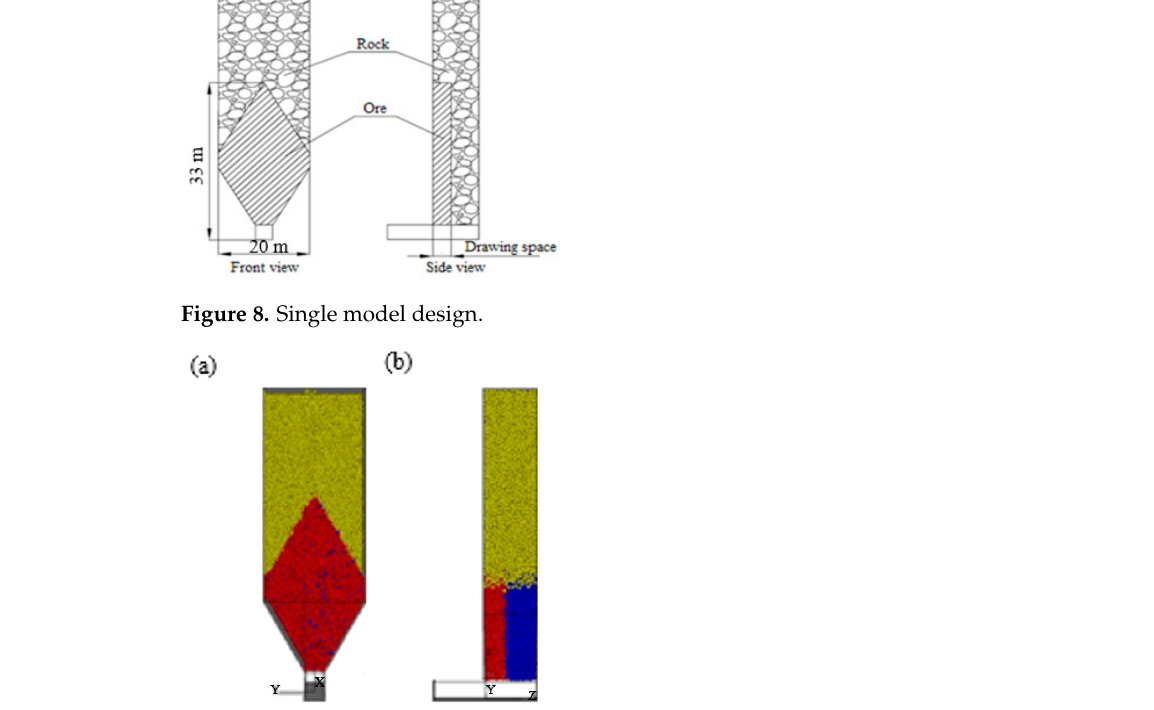
Figure 9. Initial diagram of the single model: ( a ) front view; ( b ) side view.